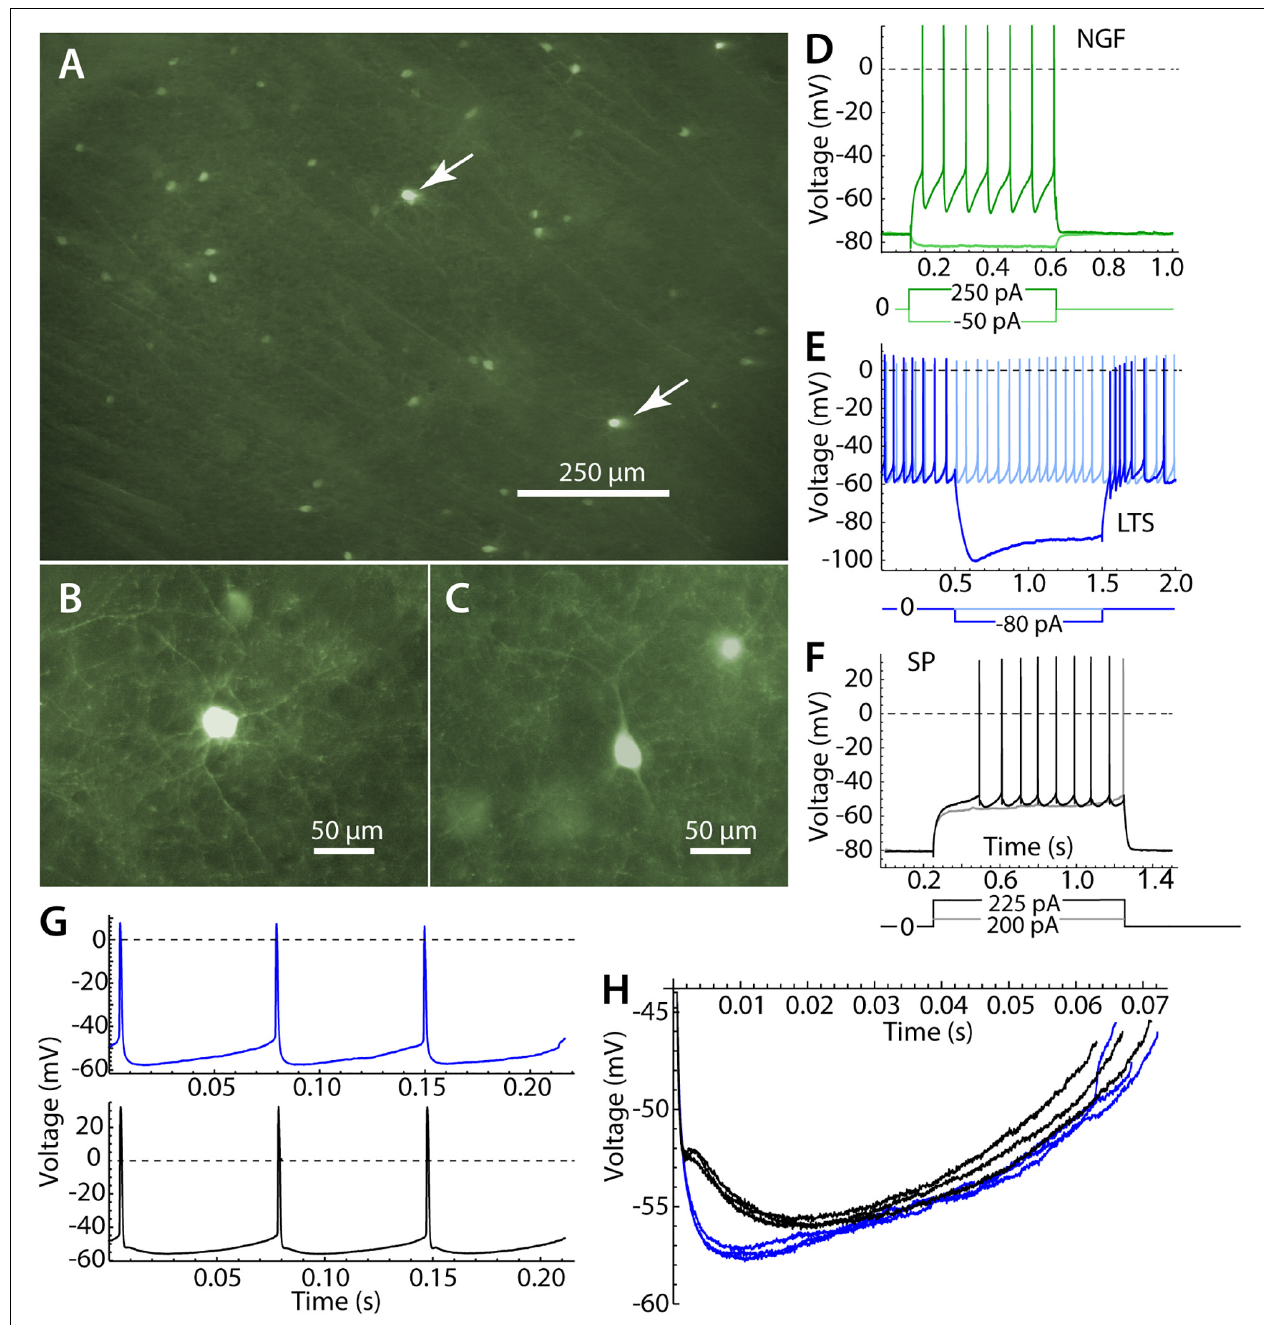
FIGURE 1 | Identification of striatal neurons. (A) Panoramic view of the striatum in parasagittal section. Most labeled cells are LTS interneurons, but there are a few neurogliaform (NGF) cells, which are brighter (arrows). (B) A NGF cell at higher magnification, characterized by many primary dendrites that branch frequently. (C) An LTS interneuron, with fewer and straighter dendrites. (D) Responses of an NGF cell to hyperpolarizing and depolarizing current pulses. Note the stable hyperpolarized membrane potential in the absence of current. (E) An LTS interneuron, with continuous autonomous firing in the absence of current, and a prominent rebound burst at the offset of a hyperpolarizing current pulse. (F) A SP neuron, with characteristic long delay to first spike in response to depolarizing currents. (G) Repetitive firing of an LTS interneuron in the absence of injected current (blue) and an SP neuron, firing repetitively (black) when depolarized to approximately match the firing rate of the LTS interneuron. (H) The interspike membrane potential trajectory of the same LTS interneuron (blue) and SP neuron (black) shown in (G) . SP neurons show separate fast and medium afterhyperpolarizations, whereas LTS interneurons have a single afterhyperpolarization.